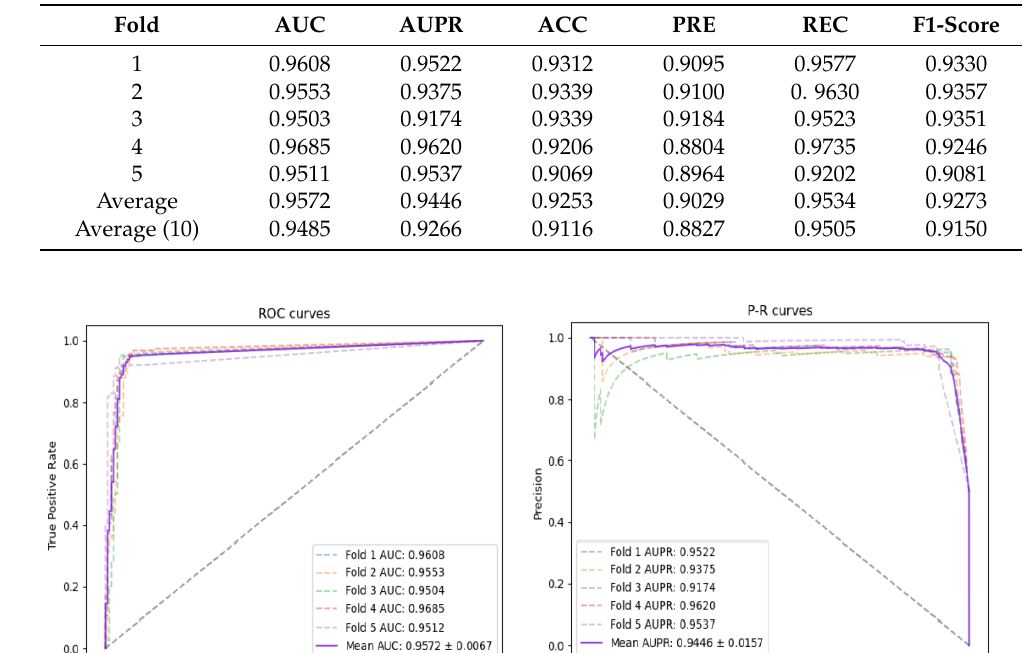
Table 5. Results of the GGCDA on the independent test